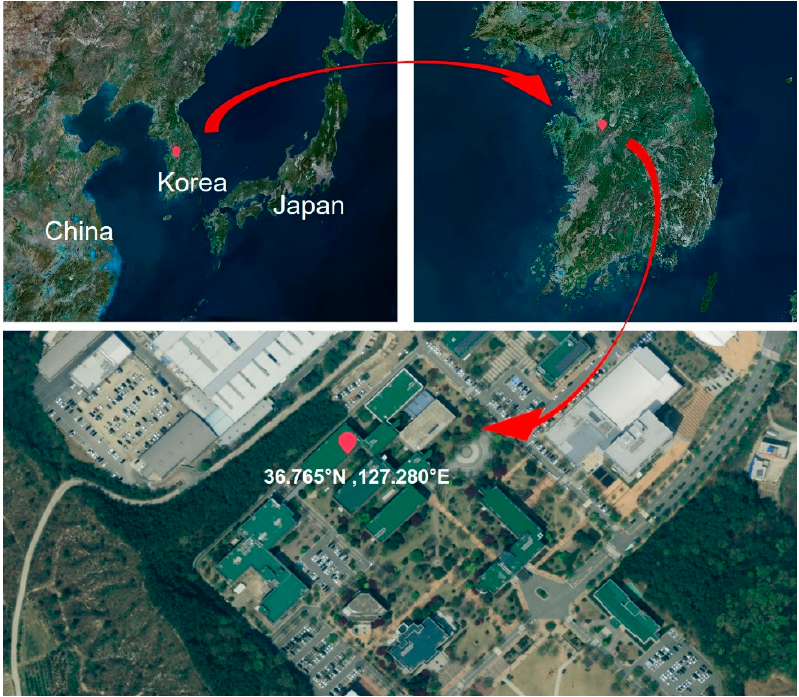
Figure 1. Location of sampling site at KOREATECH Byeongcheon Campus (36.765° N, 127.280° E).